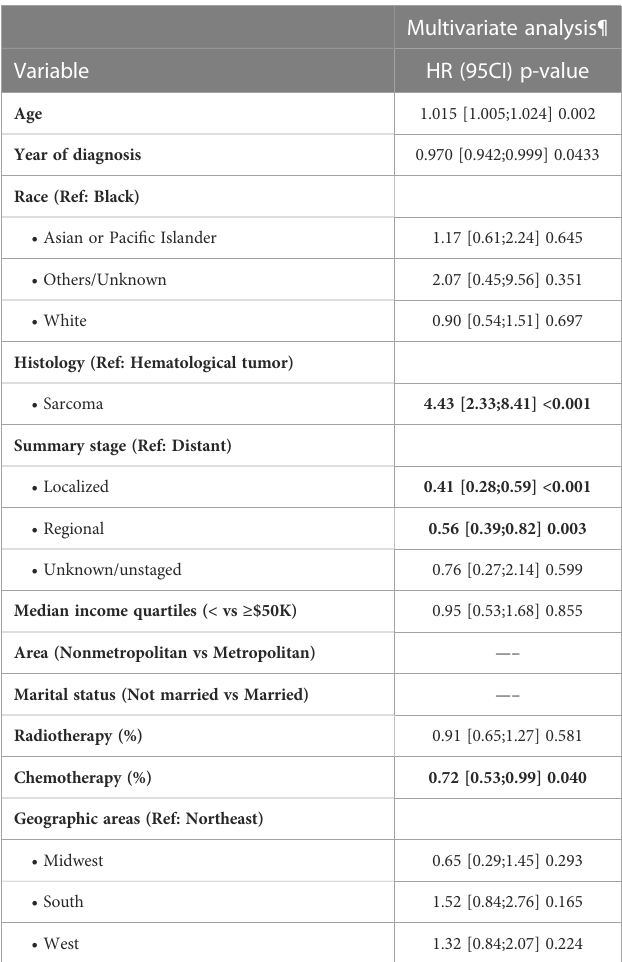
TABLE 3 Predictors of late overall mortality among the surgical subgroup using Cox regression.